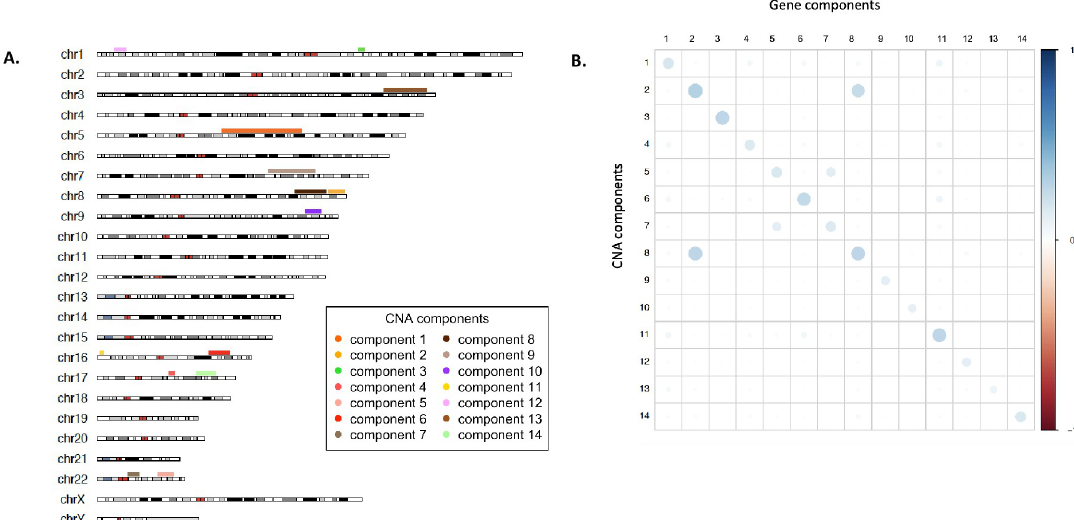
Fig 1. Results from sCCA analysis. (A) Chromosomal subregions identified by 14 CNA components. For each CNA component the region between the most distal CNA selected in that component is marked. (B) Average squared correlation between the CNA selected in CNA components and genes selected in Gene components. Correlation between Genes in components 2 and CNA in component 8 (and vice versa) are observed due possible correlation between selected CNA and long-range regulatory effects. Similar correlation is observed for components 5 & 7 as